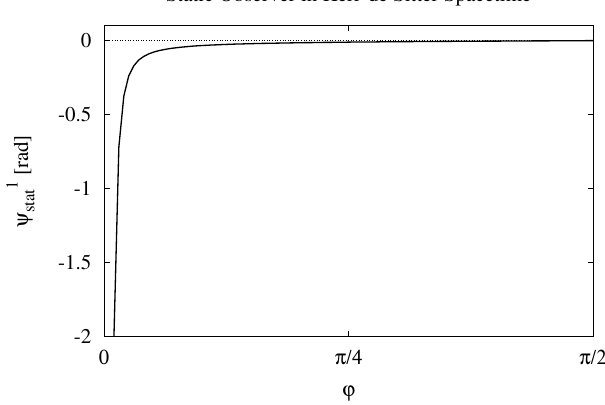
Figure 2. φ dependence of Equation (43).